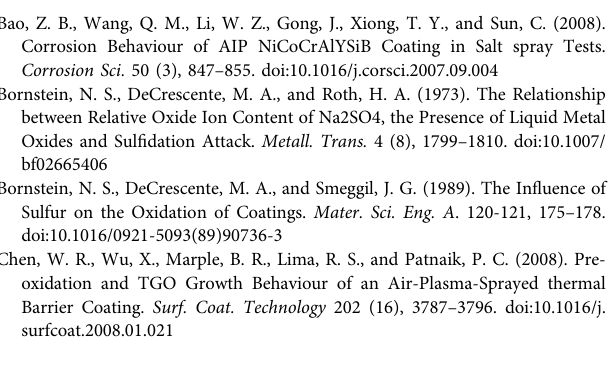
Frontiers in Materials |